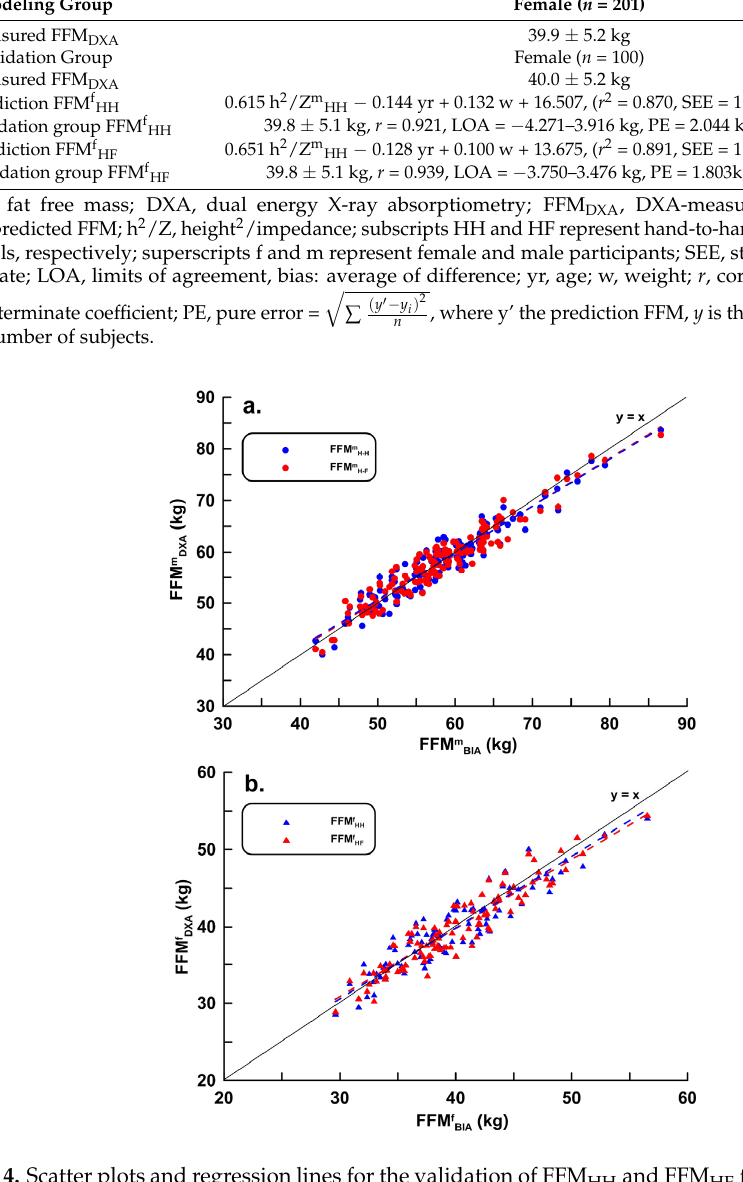
Figure 4. Scatter plots and regression lines for the validation of FFM HH and FFM HF for ( a ) male subjects ( n = 134; FFM mHH : y = 0.982 x + 0.996, r 2 = 0.926, SEE = 2.233 kg , p < 0.001; FFM mHF : y = 1.011 x − 0.577, r 2 = 0.925, SEE = 2.181 kg, p < 0.001); and ( b ) female subjects ( n = 100; FFM fHH : y = 1.054 x − 2.204, r 2 = 0.870, SEE = 1.937 kg, p < 0.001; FFM f HF : y = 1.034 x − 1.267, r 2 = 0.891, SEE = 1.776 kg, p <